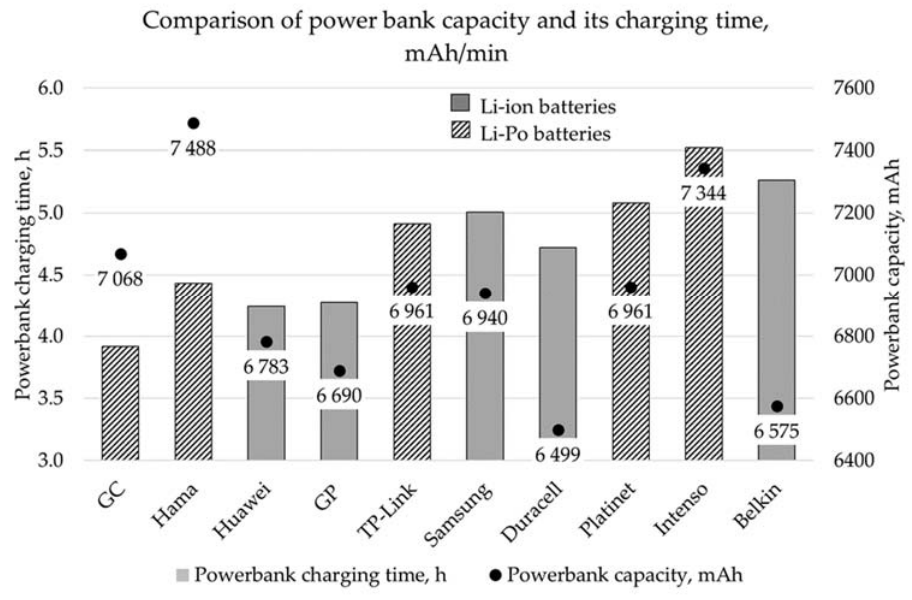
Figure 11. Comparison of power bank capacity and charging time.